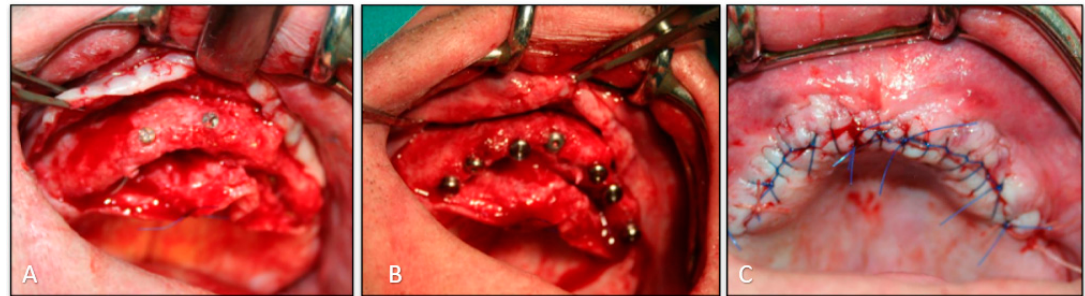
Figure 7. Surgical planning of the implants’ placement.